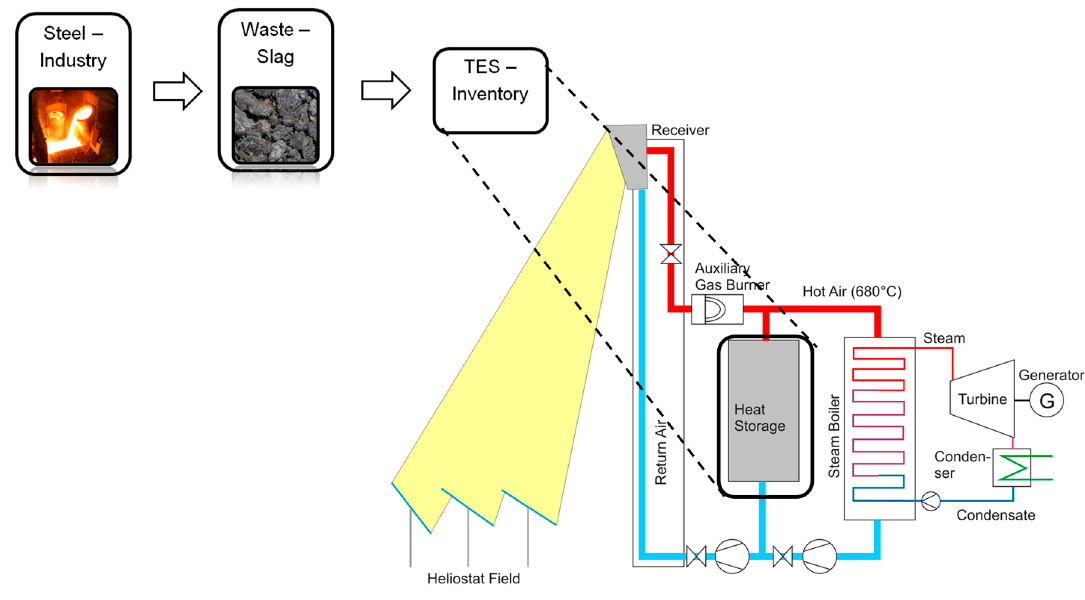
Figure 1. Flowsheet of slag reuse as a thermal energy storage (TES) inventory for a concentrated solar power (CSP) plant with an open volumetric receiver [12].